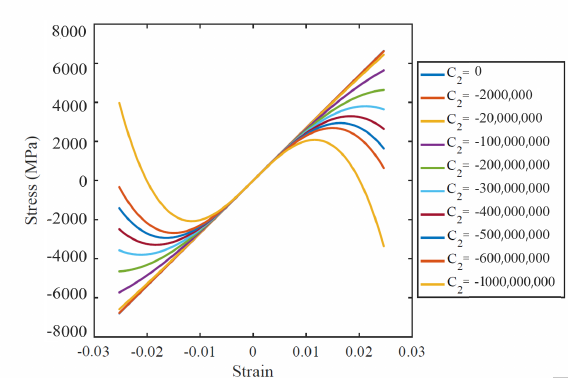
Figure 10. Stress-strain curves under different second order